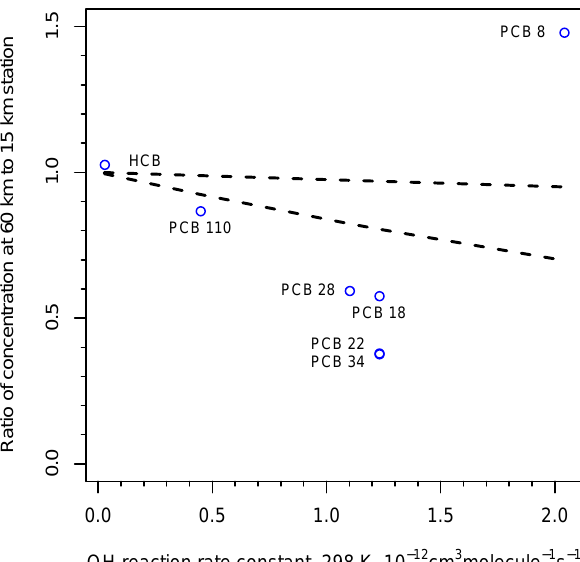
Fig. 4. Ratio of 60-km station to 15-km station (13:18–14:48 to 06:20–07:50local time) PBT concentration at 8.5m height versus hydroxyl radical reaction rate constant for PBTs in air over Lake Su- perior on 14 July 2006 (symbols). The calculated reduction in con- centration by OH-radical reaction over a 7-h period is shown by the dashed lines for a typical range in daytime, mid-latitude, continental OH concentration of 1 × 10 6 (upper line) to 7 × 10 6 moleculescm − 3 (lower